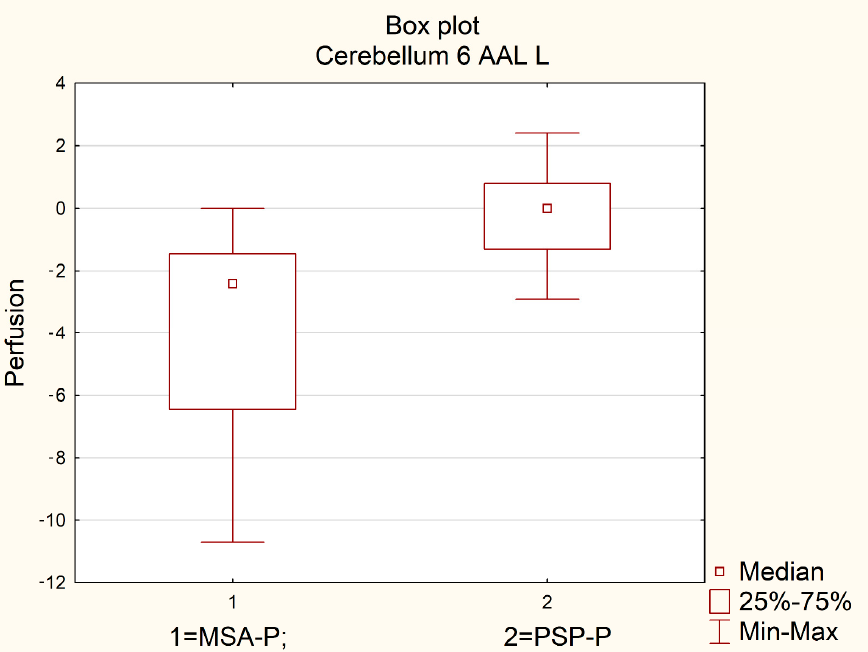
Figure 1. Comparison of perfusion in the left anterior quadrangular lobule (AAL L) in MSA-P and